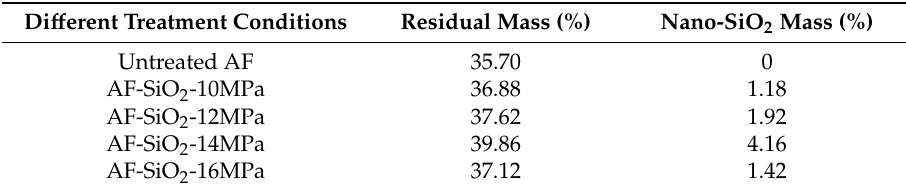
Table 2. Residual mass of the aramid fibers treated in Sc-CO 2.